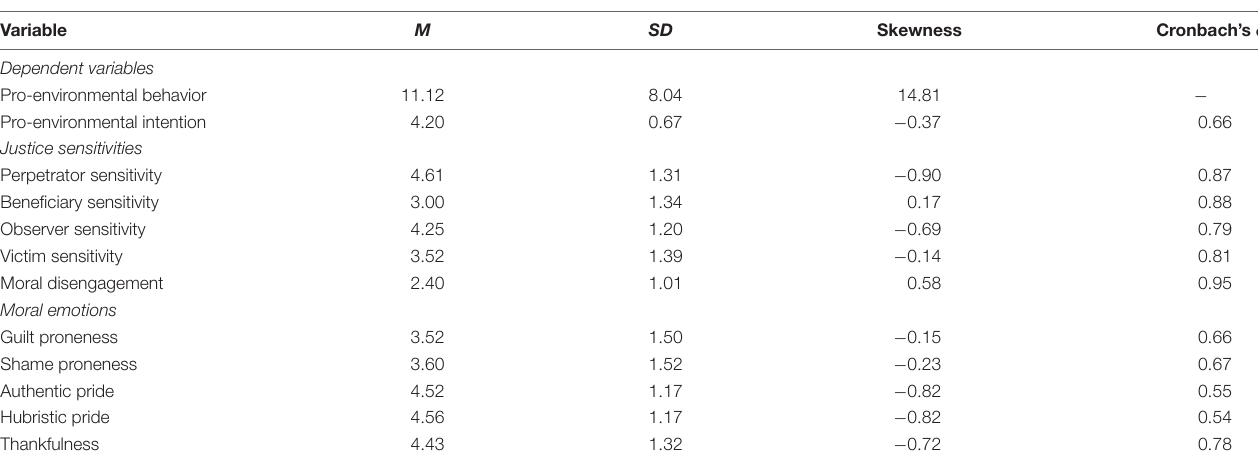
TABLE 5 | Descriptive statistics and internal consistency of all focal measures in Study